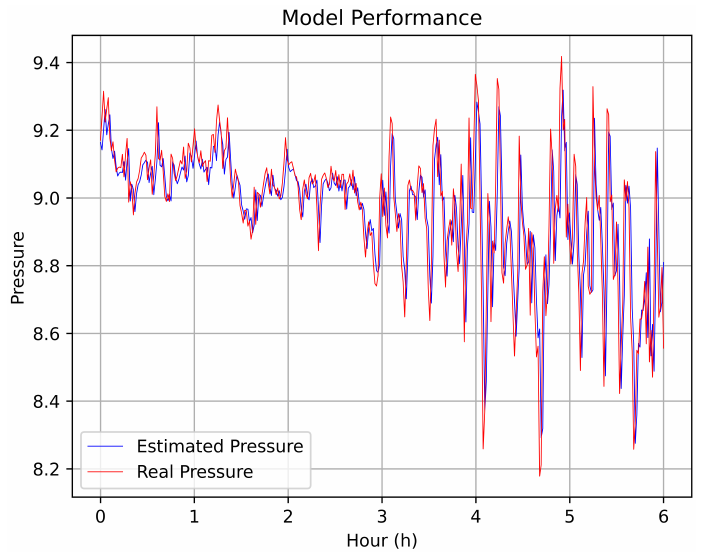
Figure 23. Analysis of the current pressure and that inferred by the neural network for the validation data. Source: